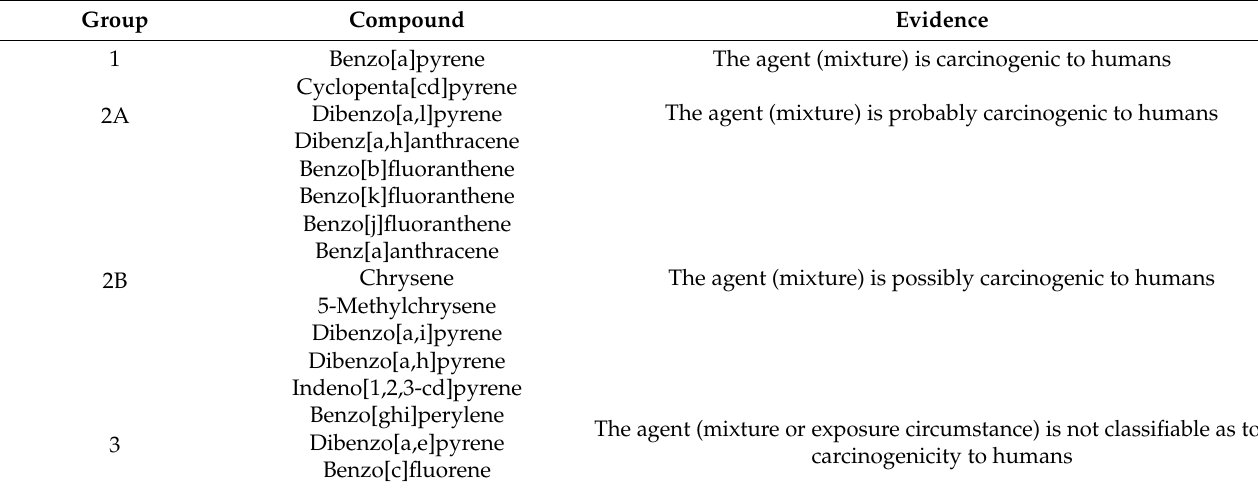
Table 2. International Agency for Research on Cancer carcinogenicity classification of 16 polycyclic aromatic compounds present in